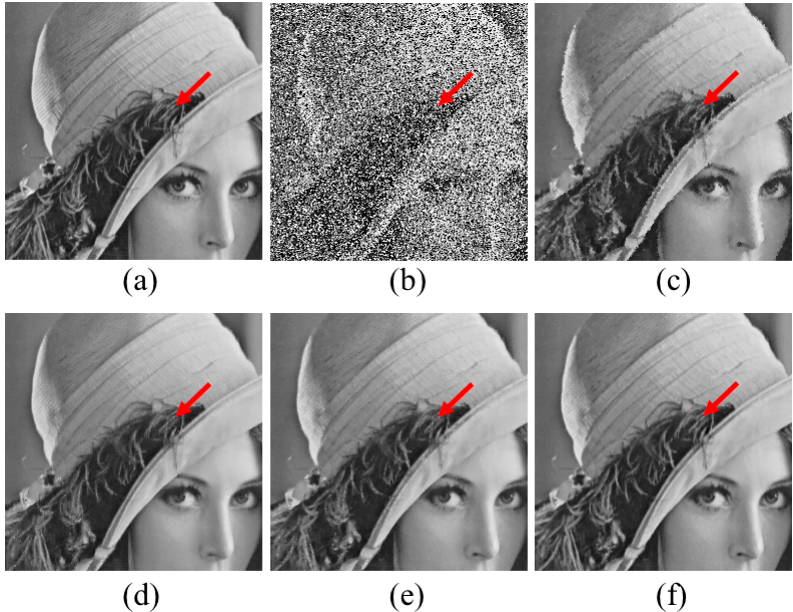
Figure 5. Denoised Lena images at the noise level of 0.5. ( a ) is the noise-free image, ( b ) is the noisy image, ( c )–( f ) are denoised images using AMF, PANO-L 1 , TV-L 0 , and the proposed FDLCP-L 0 , respectively. Table 1. Quantitative measures at the salt and pepper impulse noise level of 0.5. Images Quantitative